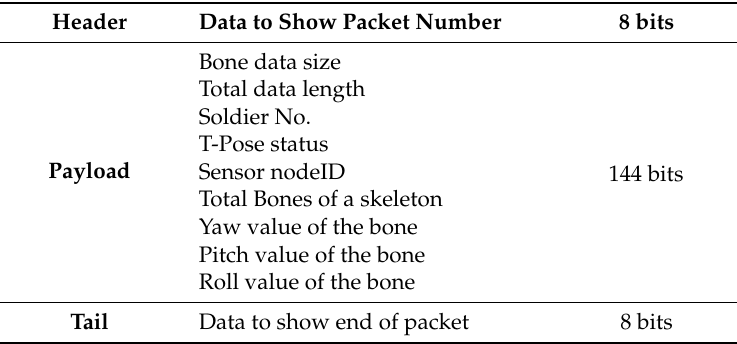
Table 2. Data structure of a packet.